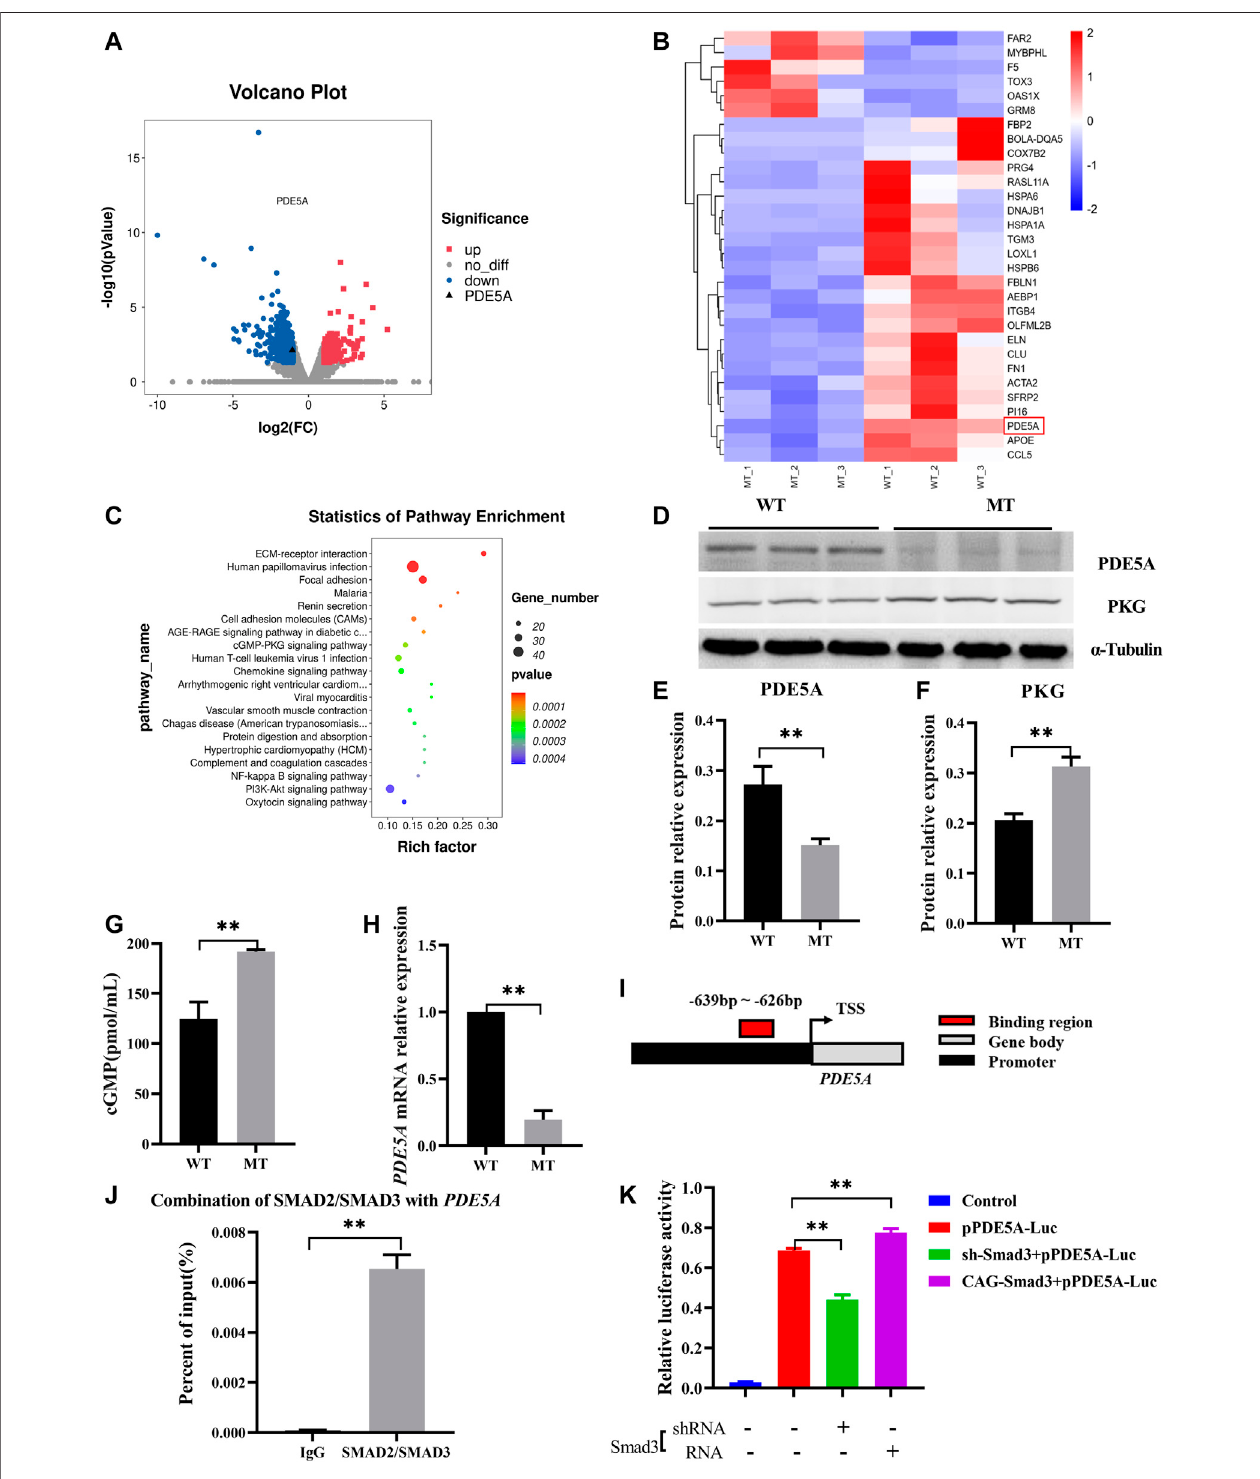
FIGURE4 | MSTN regulates PDE5A-cGMP-PKGpathway expression via SMAD2/SMAD3. (A) Volcano plot ofdifferential geneexpression analysis. (B) Clustering heat map of differential gene expression. (C) KEGG analysis of DEGs between WT and MT groups. (D – F) Expression of PDE5A and PKG protein in heart of MT and WT cattle. (G) cGMPcontentofMTandWTcattleheart. (H) ExpressionofPDE5AmRNAinheartofMTandWTcattle. (I) SchematicrepresentationofSMAD2/SMAD3binds the PDE5A promoter region. (J) ChIP-qPCR detected the binding of SMAD2/SMAD3 to the PDE5A promoter region in cattle hearts with MT. (K) Promoter activity of PDE5A wasdeterminedbyaluciferaseassay.Alldataarepresentedasmean±SD.* p < 0.05,** p < 0.01,ns:nosigni fi cant; t -testswereusedtocalculatethe p -values.